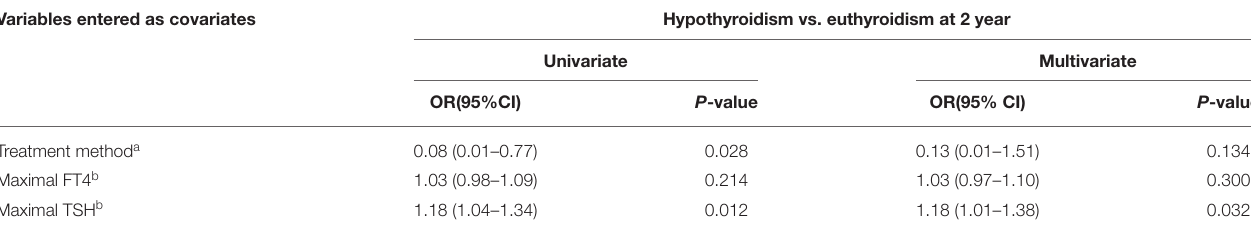
TABLE 4B | Results of univariate and multivariate regression analysis of risk factors for hypothyroidism versus euthyroidism at 2 year after the onset of SAT. Variables entered as